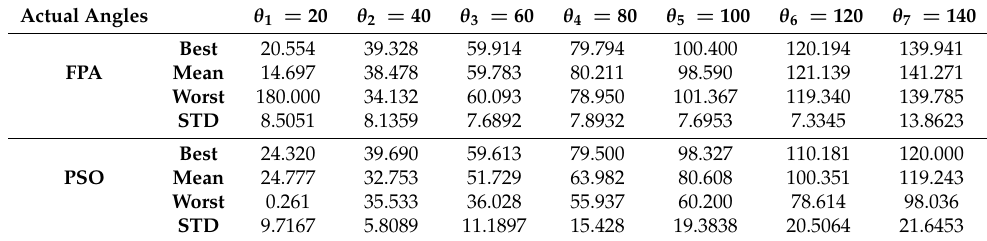
Table 2. Estimation accuracy and STD for seven targets at SNR = − 5 dB.